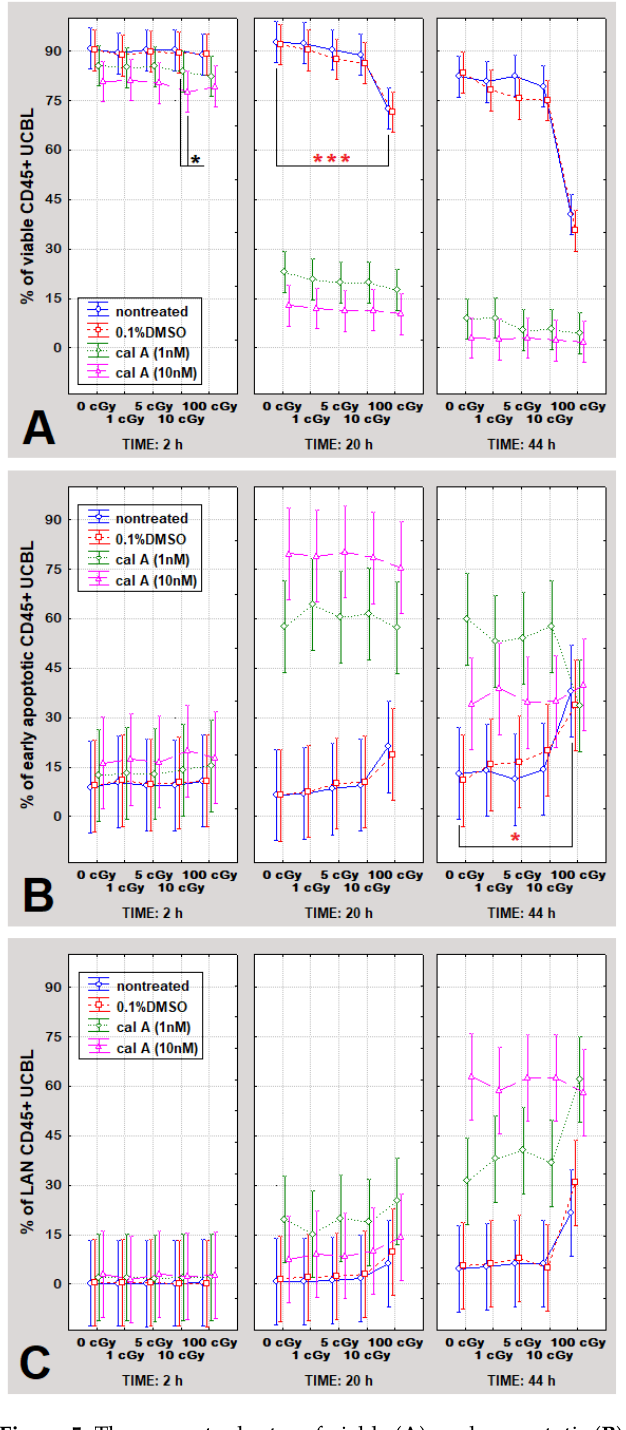
Figure 5. The percentual rates of viable ( A ), early apoptotic ( B ), and late apoptotic/necrotic CD45+ UCBL ( C ) at 2, 20, and 44 h post-irradiation. Cells were treated with 0.1% DMSO, cal A (1 nM), and cal A (10 nM), irradiated with 0, 1, 5, 10, and 100 cGy, and analyzed by the annexin V-FITC/PI assay 2, 20 and 44 h post-irradiation. Each data point shows the mean value and ± 0.95 confidence interval from 3 experiments. * indicates statistically significant difference between irradiated and unirradiated cells; * statistically significant differences between treatments. * p < 0.05, *** p < 0.00099.